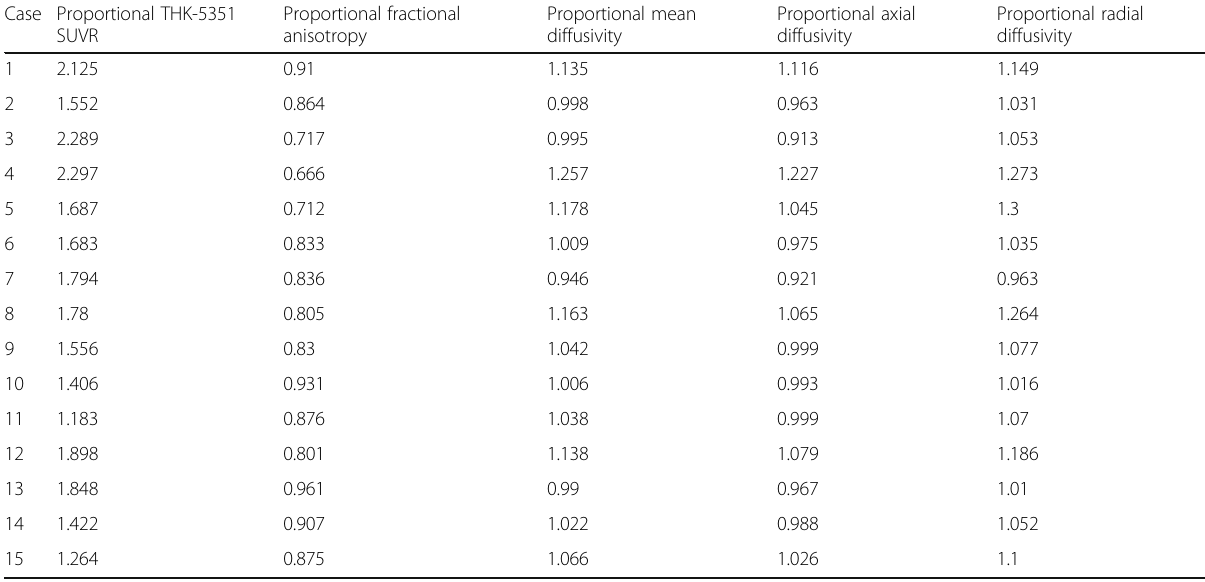
Table 2 The proportional 18 F-THK-5351 SUVR and diffusion tensor imaging parameters Case Proportional THK-5351